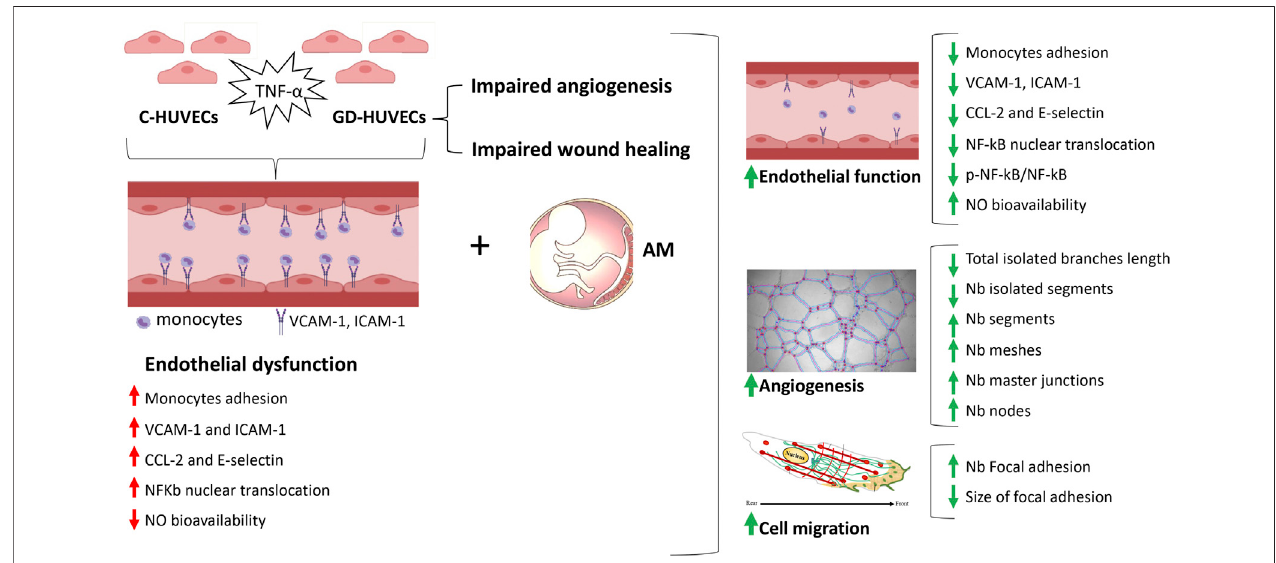
FIGURE8| Schematicrepresentationofthemain fi ndingsfromthestudy.Gestationaldiabetesendothelialcells(GD-HUVECs)haveshownincreasedin fl ammation leading to endothelial dysfunction as well as impaired angiogenesis and wound healing. By using this cellular model that reproduces a typical diabetic foot ulcer endothelium, the amniotic membrane (AM) was able to restore endothelial function, enhance angiogenesis, and improve wound healing.